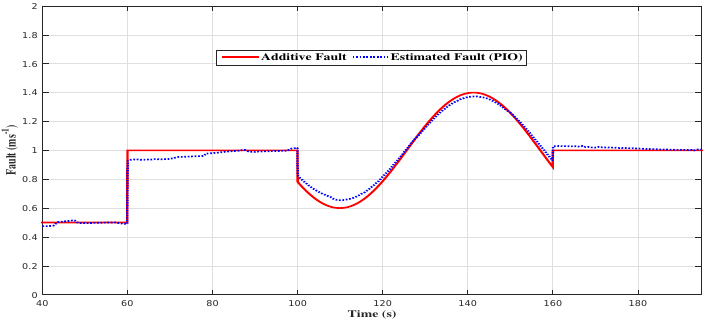
Figure 10. The additive fault with the proportional and integral